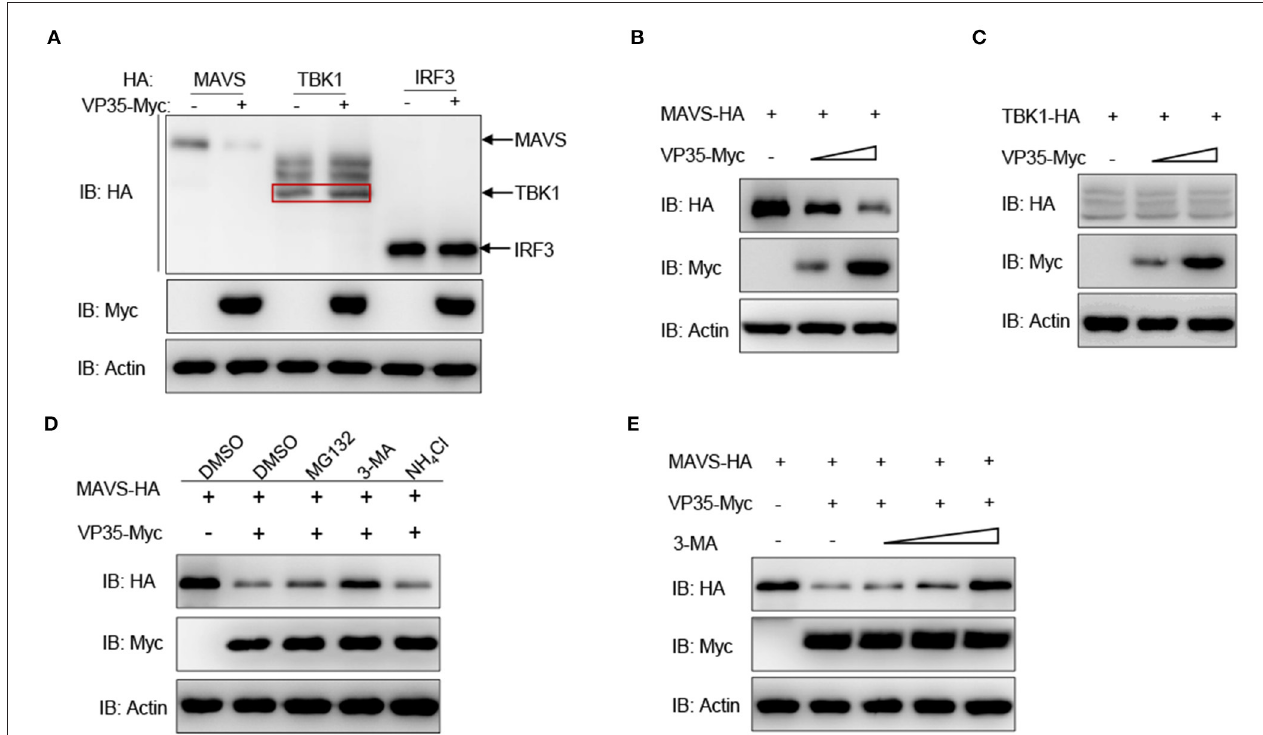
FIGURE 4 | VP35 degrades MAVS through the autophagy pathway. (A) EPC cells were seeded in six-well plates overnight and co-transfected with 1 µ g of MAVS/TBK1/IRF3-HA and 1 µ g of empty vector or VP35-Myc for 24h. The WCLs were subjected to IB with the anti-HA, anti-Myc, and anti- β -actin Abs. (B,C) EPC cells were seeded into six-well plates overnight and co-transfected with 1 µ g MAVS-HA (B) or TBK1-HA (C) plus various concentration of VP35-Myc (0, 1, or 2 µ g, empty vector was used to make up the rest). After 24h, the WCLs were subjected to IB with anti-Myc, anti-HA, and anti- β -actin Abs. (D) Effects of inhibitors on VP35-mediated degradation of MAVS. EPC cells were seeded in six-well plates overnight and co-transfected with 1 µ g MAVS-HA and 1 µ g VP35-Myc. At 18h post-transfection, the cells were treated with the dimethyl sulfoxide (DMSO), MG132 (20 µ M), 3-MA (2mM), or NH 4 Cl (20mM) for 6h prior to being harvested for IB analysis of WCLs with the anti-HA, anti-Myc, and anti- β -actin Abs. (E) VP35-induced MAVS degradation is rescued by 3-MA in a dose-dependent manner. EPC cells were seeded in six-well plates overnight and co-transfected the indicated plasmids. At 18h post-transfection, the cells were treated with DMSO or 3-MA (1, 2, or 4mM) for 6h. Then, the cells were harvested for IB with the Abs indicated. All experiments were repeated at least three times with similar